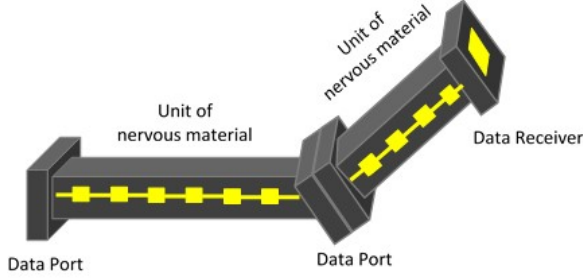
Figure 16. Sample of nervous material with embedded sensors and actuators with connectivity definition.